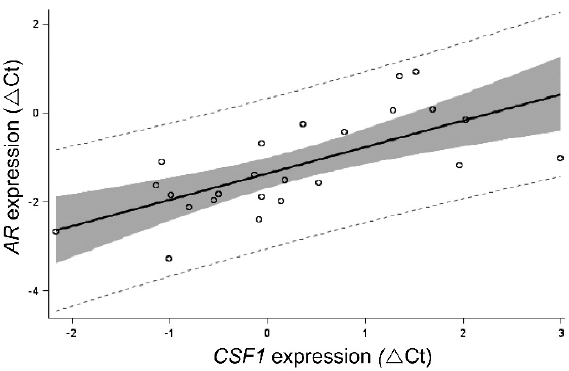
Figure 3. Relationship between CSF1 expression and AR expression in testes from control boars.